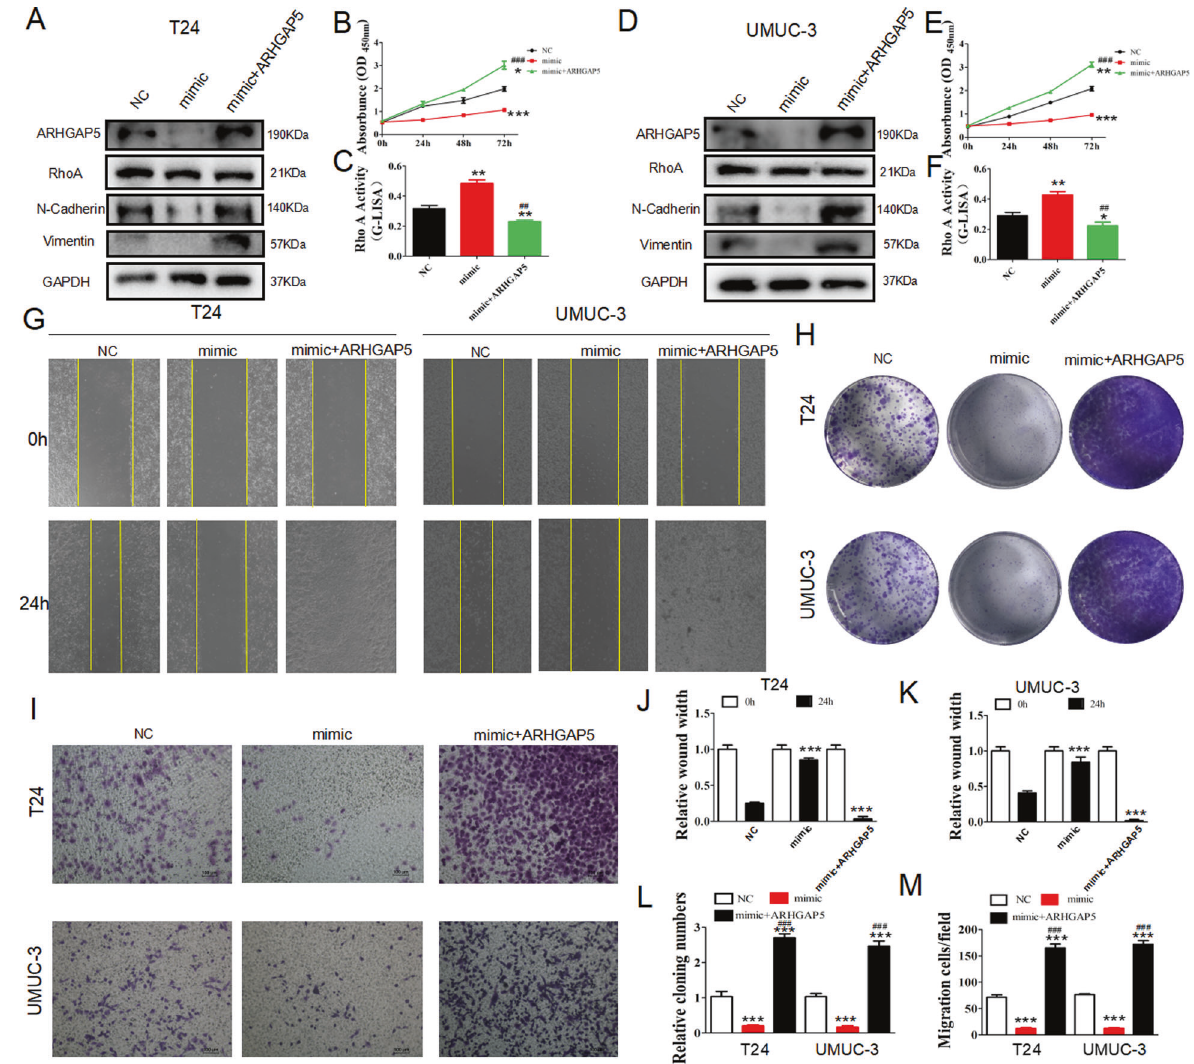
Fig. 6 Upregulation of ARHGAP5 rescued the ability of proliferation and invasiveness of BC cells after miR-516b-5p overexpression. T24 and UM-UC-3 cells were transfected with empty vector (NC), hsa-miR-516b-5p mimics (mimic), hsa-miR-516b-5p mimics together with ARHGAP5 overexpression vector (mimic + ARHGAP5). ( A , D ) Cells were then subjected to western blot analysis with anti-ARHGAP5, anti-N- Cadherin, anti-Vimentin and anti-GAPDH. GAPDH was used as loading control. ( B , E ) CCK-8 assays of transfected T24 and UM-UC-3 cells at 0 h, 24 h, 48 h and 72 h after transfection were performed ( *** P < 0.001, ** P < 0.01, * P < 0.05 versus NC, ### P < 0.001 versus si-circUBE2K) (C and F) RhoA G-LISA activation assays were used to evaluate RhoA activity in transfected T24 and UM-UC-3 ( ** P < 0.01, * P < 0.05 versus NC, ## P < 0.01 versus si-circUBE2K). ( G , J , K ) Wound healing assays at 0 h and 24 h were done to assess cell migration ability (Left panel: T24-NC, T24-mimic, T24-mimic + ARHGAP5; Right panel: UM-UC-3-NC, UM-UC-3-mimic, UM-UC-3-mimic + ARHGAP5) ( *** P < 0.001 versus NC). ( H , L ) Colony formation assays of transfected T24 and UM-UC-3 were carried out to test cell proliferation potential.( *** P < 0.001 versus NC, ### P < 0.001 versus si-circUBE2K) ( I , M ) Transwell cell migration assays of transfected T24 and UM-UC-3 were carried out to evaluate cell invasion ability( *** P < 0.001 versus NC, ### P < 0.001 versus